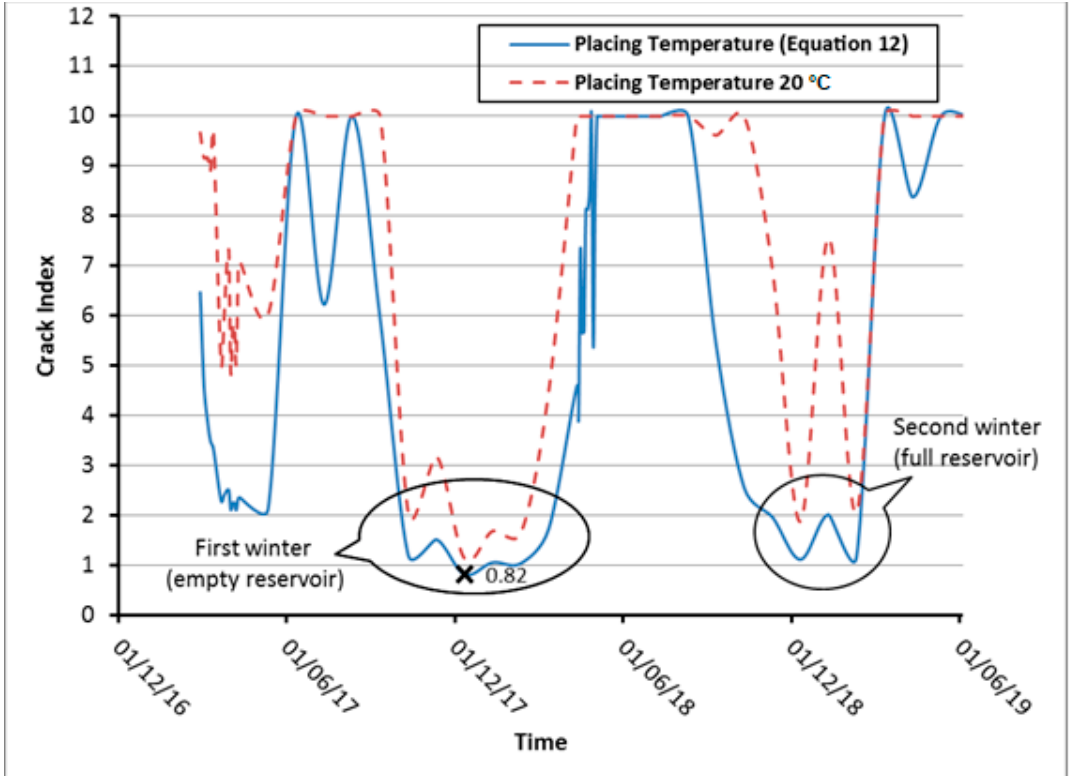
Figure 12. Crack index variation at level 51.5 m and 0.1 m from downstream edge.